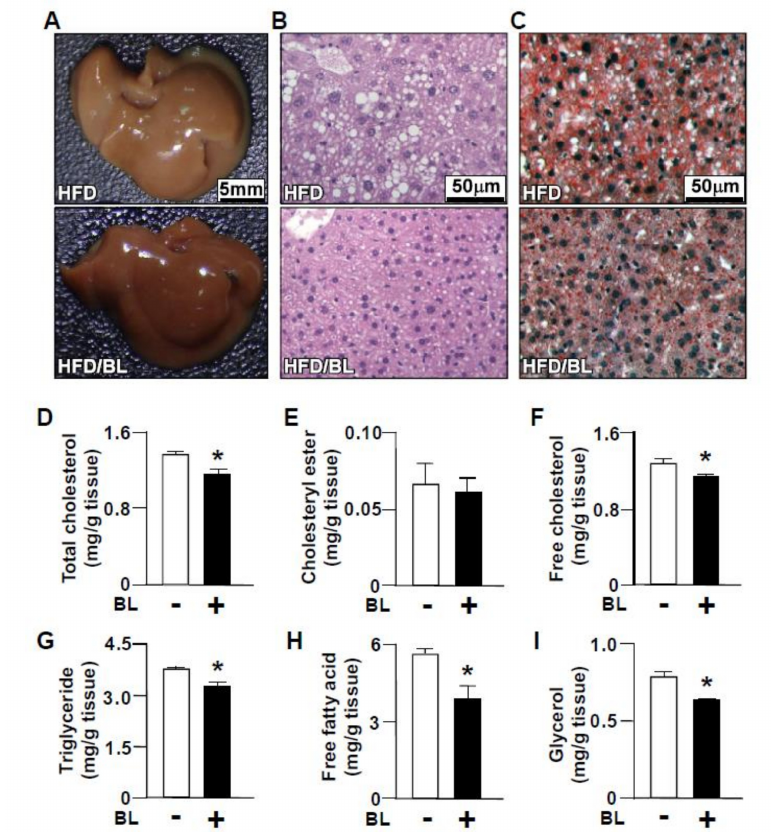
Figure 2. Bromelain decreases HFD-induced lipid accumulation in the liver of HFD-fed mice. Eight-week-old C57BL / 6 mice were fed with HFD and were treated daily with bromelain (20 mg / kg) or vehicle (PBS) for 12 weeks. ( A – C ) The liver appearance and representative histological images by hematoxylin and eosin ( H , E ) staining and oil red O staining of the liver tissues. ( D – I ) The hepatic levels of total cholesterol, free cholesterol, cholesteryl ester, triglycerides, free fatty acids, and glycerol. The results are presented by the mean ± SEM from 10 mice. * p < 0.05 vs. vehicle group. BL: